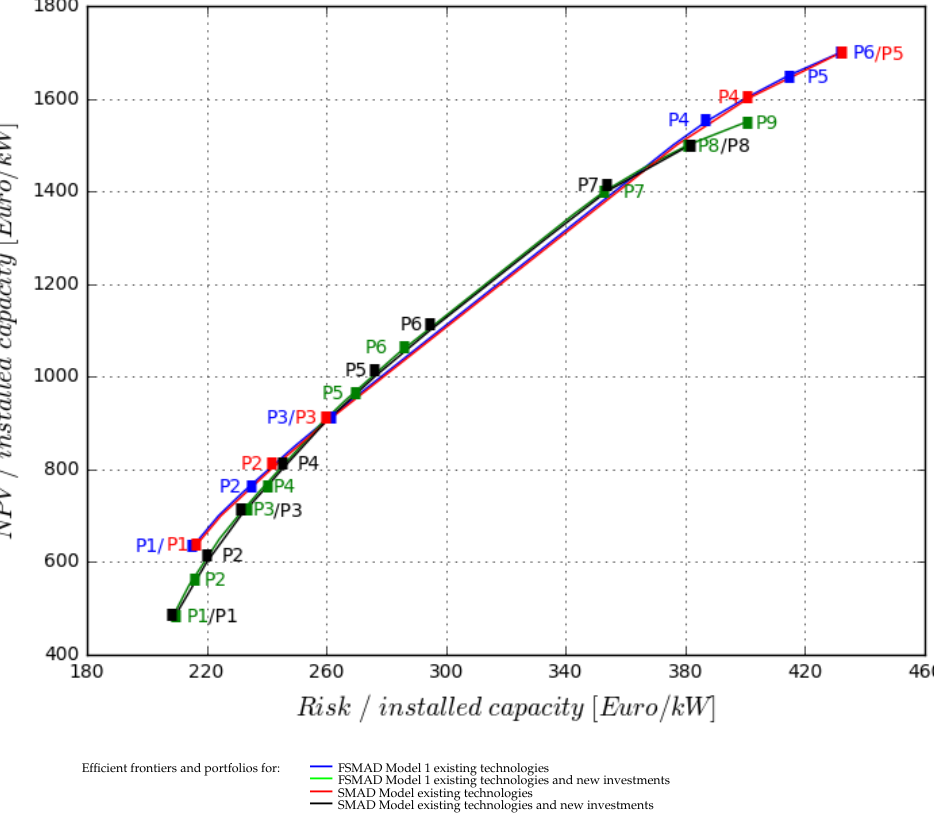
Figure 2. Comparison of efficient frontiers obtained with the FSMAD Model 1 and the SMAD